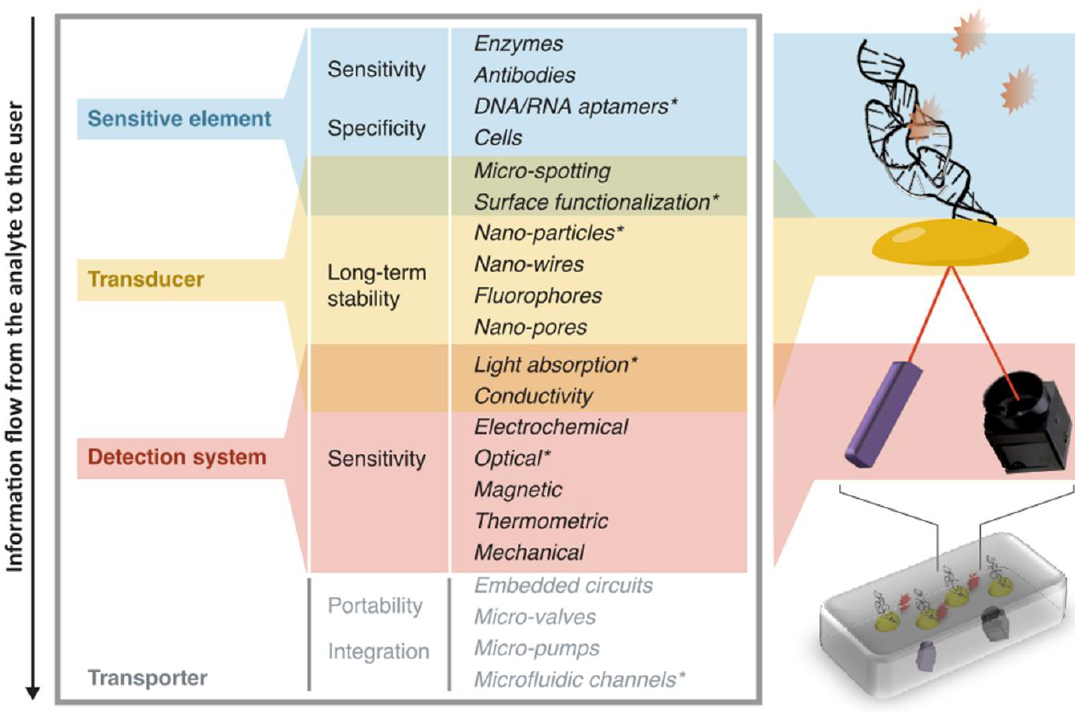
Figure 1. Functional partitioning of a biosensor. Schematic view of the parts that compose a biosensor, conceptually and physically, along the information flow from the analyte to the user. Each functional partition is indicated with a specific color. For each partition, we indicate qualities that are crucial for implementation in low-resource settings, and a list of components/properties specific to that partition. Elements marked with * are the ones illustrated in the picture on the right, which compose an example of a portable biosensor described in [19].